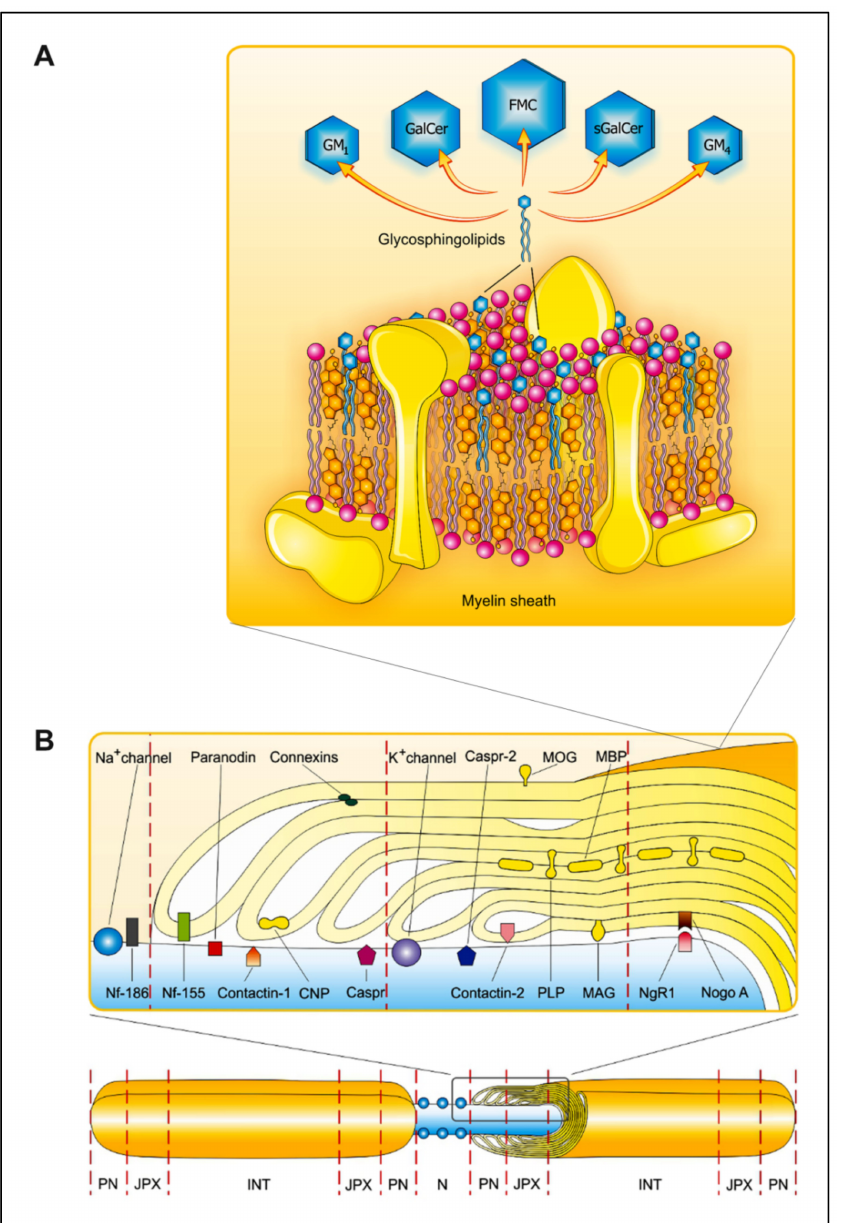
Figure 1. Composition of the myelin sheath in the central nervous system. ( A ) The diagram presents the distribution of the major myelin components, specifically complex lipids that comprise cholesterol, phospholipids and glycosphingolipids (GSLs), as well as proteins in the CNS. GSLs include the following compounds: fast migrating cerebrosides (FMCs), galactosylceramide (GalCer), mono- sialoganglioside (GM1), sialosyl-galactosylceramide (GM4) and sulfatide (sGalCer). Lipids such as cholesterol, PLs and GalCer remain in a relatively constant molar ratio, which is 2:2:1. The myelin components are indicated as follows: cholesterol in orange, PLs in pink, GSLs in blue and proteins in yellow. ( B ) Myelinated regions of axon are interspersed with non-myelinated ones, designated as nodes of Ranvier (N). Three domains can be distinguished within myelinated regions: paranode (PN), juxtaparanode (JXP) and internode (INT). Distribution of the proteins characteristic for these domains, along with Na and K channels, is also displayed. Abbreviations: Caspr—Contactin-associated protein, CNP—2 (cid:48) 3 (cid:48) -cyclic-nucleotide 3 (cid:48) -phospodiesterase, NgR1—Nogo-receptor 1, Nogo A—neurite outgrowth inhibitor A, MAG—myelin-associated glycoprotein, MBP—myelin basic protein, MOG— myelin oligodendrocyte glycoprotein, Nf-155—Neurofascin 155, Nf-186—Neurofascin 186, PLP— proteolipid protein. Adapted from reference [28] and